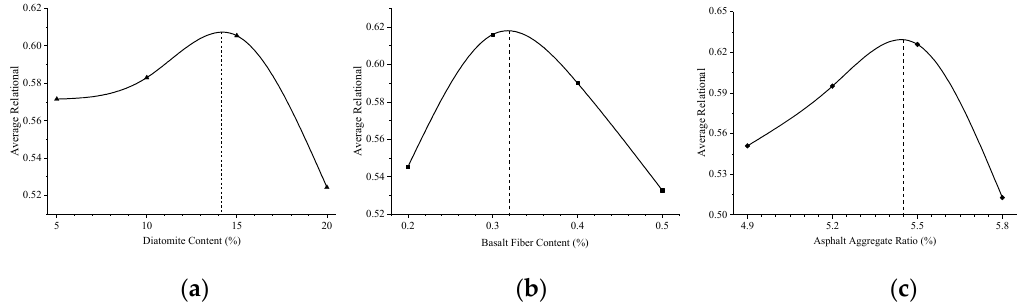
Figure 2. The trend of average correlation grade with the level of each evaluation index: ( a ) The trend of average correlation grade with diatomite content; ( b ) the trend of average correlation grade with basalt fiber content; ( c ) the trend of average correlation grade with asphalt-aggregate ratio content.